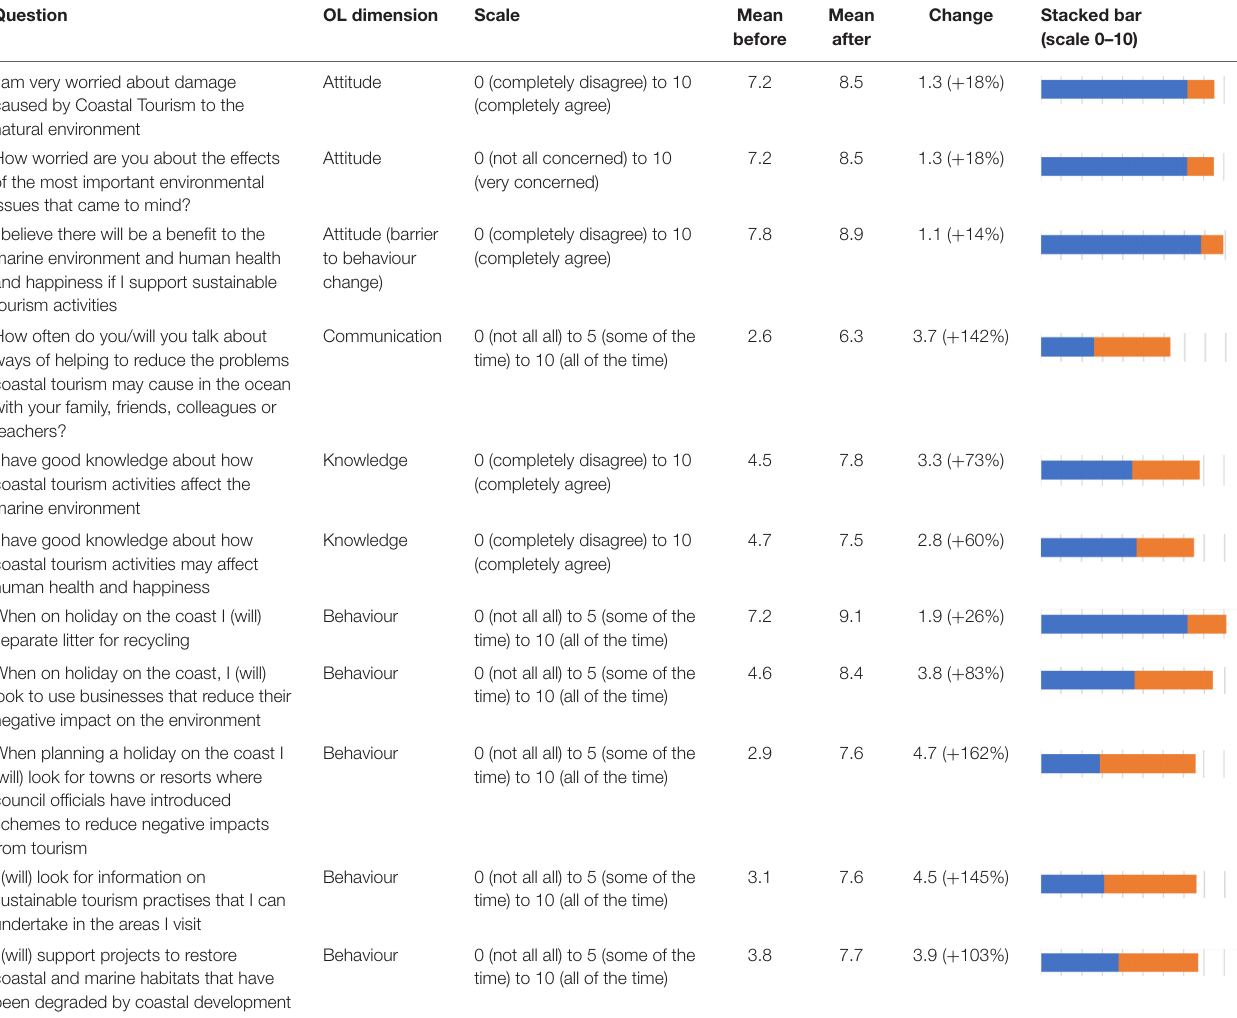
TABLE 6 | Pre- and post-survey scaled question results, summarised by OL dimension and percentage change. OL dimension Mean Mean before after